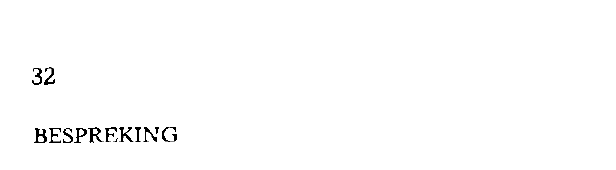
SLMPTOOMBEELDE VAN PERSONE MET VERWORWE VERBALE APRAKSIE